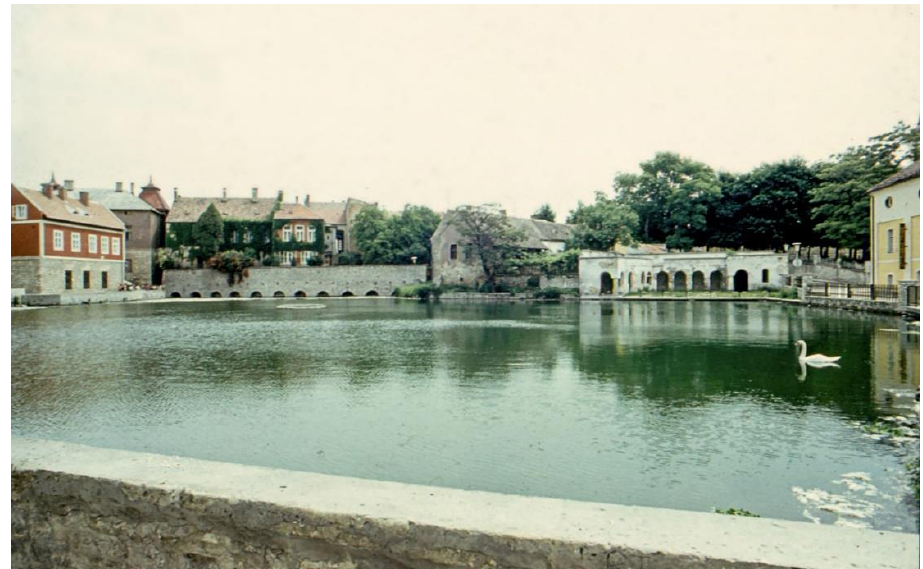
Figure 7. Lake Malom of Tapolca which developed by the damming of a stream, but it is also sup- plied by luke-warm karst springs (therefore, the water temperature is 18 – 20 °C) (the spring water originates from Sarmatian limestone) (own